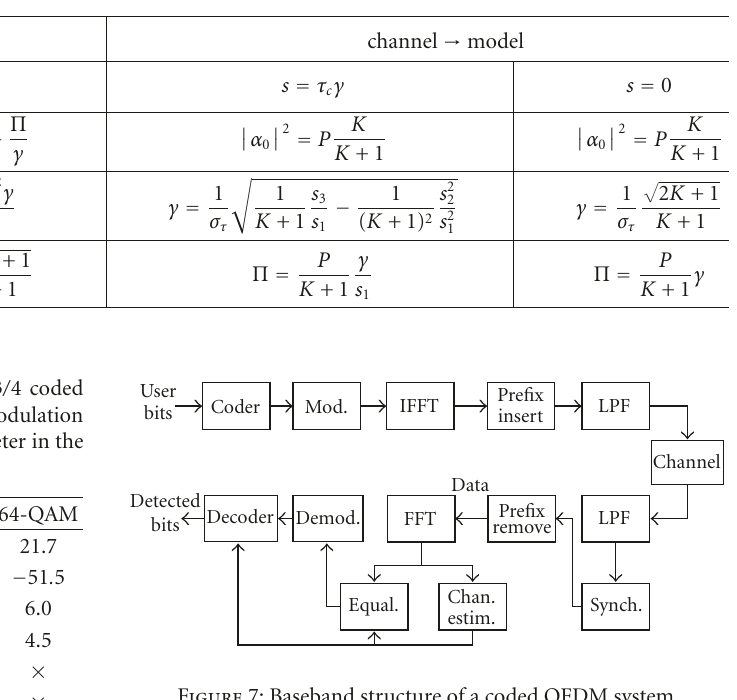
Figure 7: Baseband structure of a coded OFDM system.